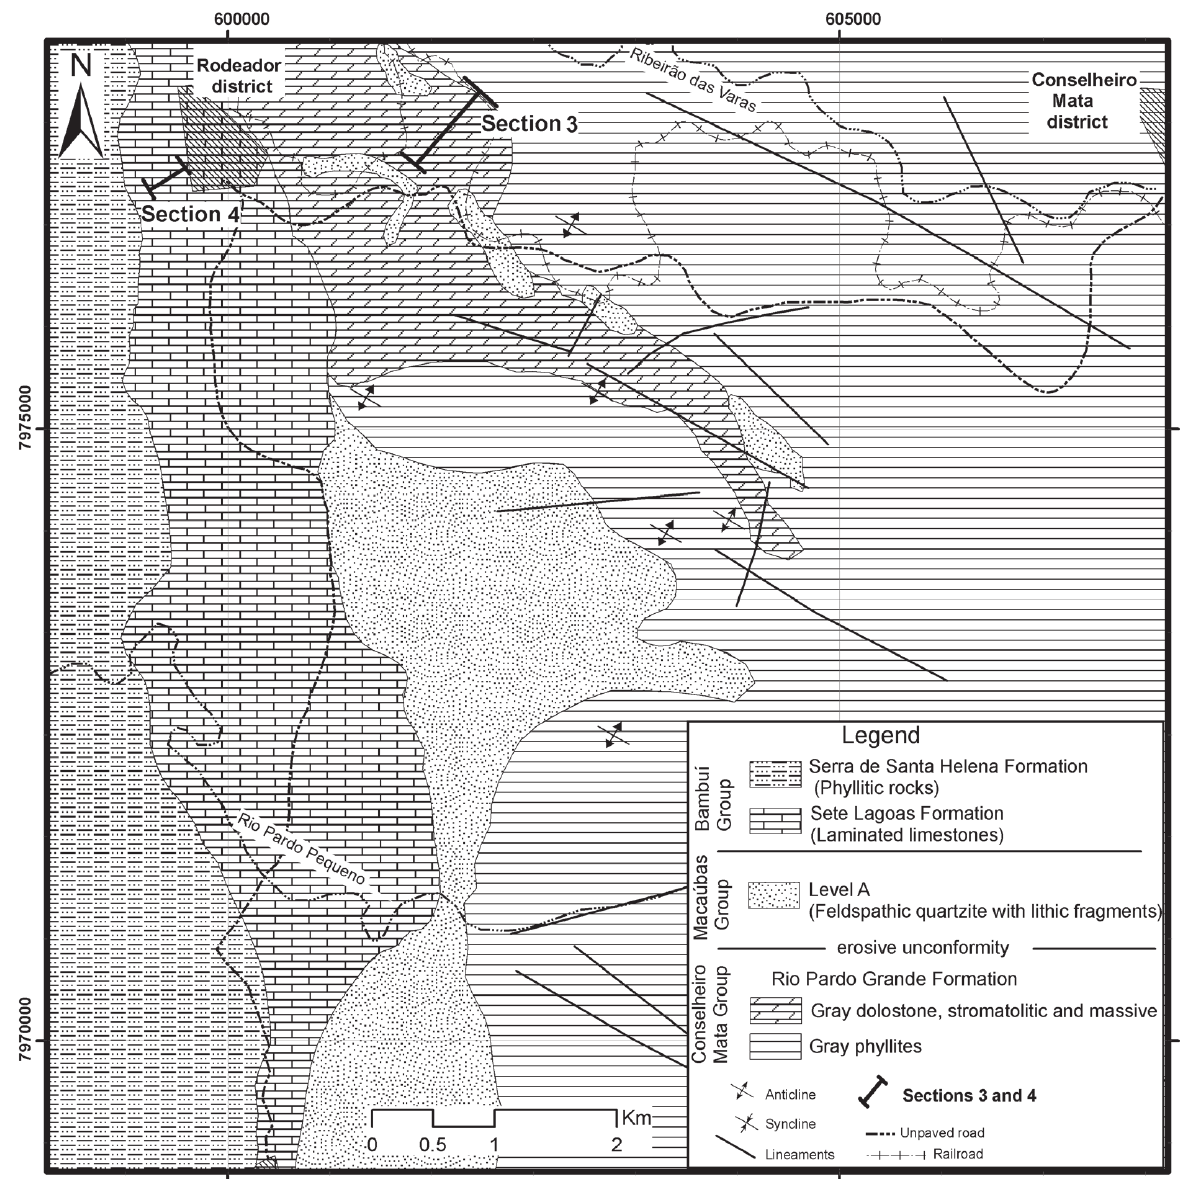
Figure 3 - Simplified geological map of the Conselheiro Mata and Rodeador districts. Lines indicate location of the studied chemostratigraphic sections (modified from Baptista et al.